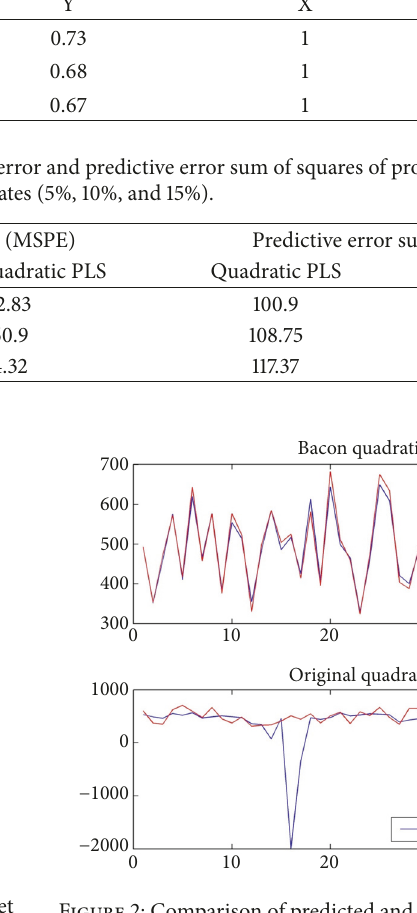
Figure 2: Comparison of predicted and actual values of test dataset in case of quadratic and robust quadratic PLS regression on 10% contaminated data.